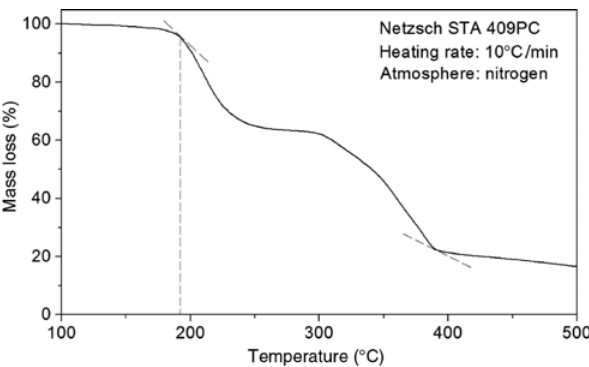
Figure 1: TGA of [Ch][Tau] IL. The TGA curve showed the mass loss of organic materials as they decomposed upon heating. The inflection points at 192 ° C and 390 ° C could be defined as the start and finish of rapid pyrogenic